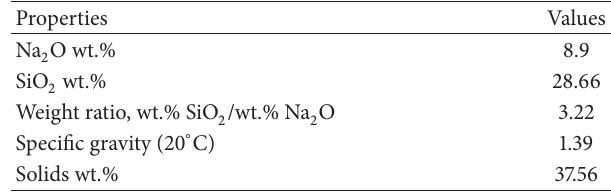
Table 3: Properties of sodium silicate (provided by National Silicates Ltd.).